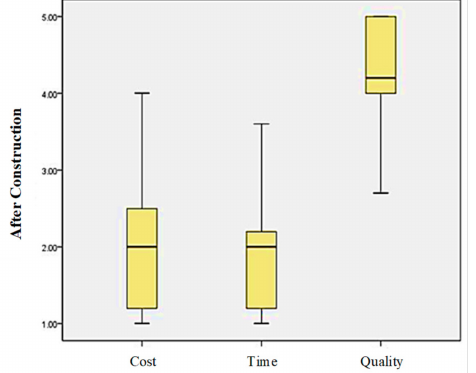
Figure 3. Comparison of changes in indicators (cost, time, quality) in the during construction stage.